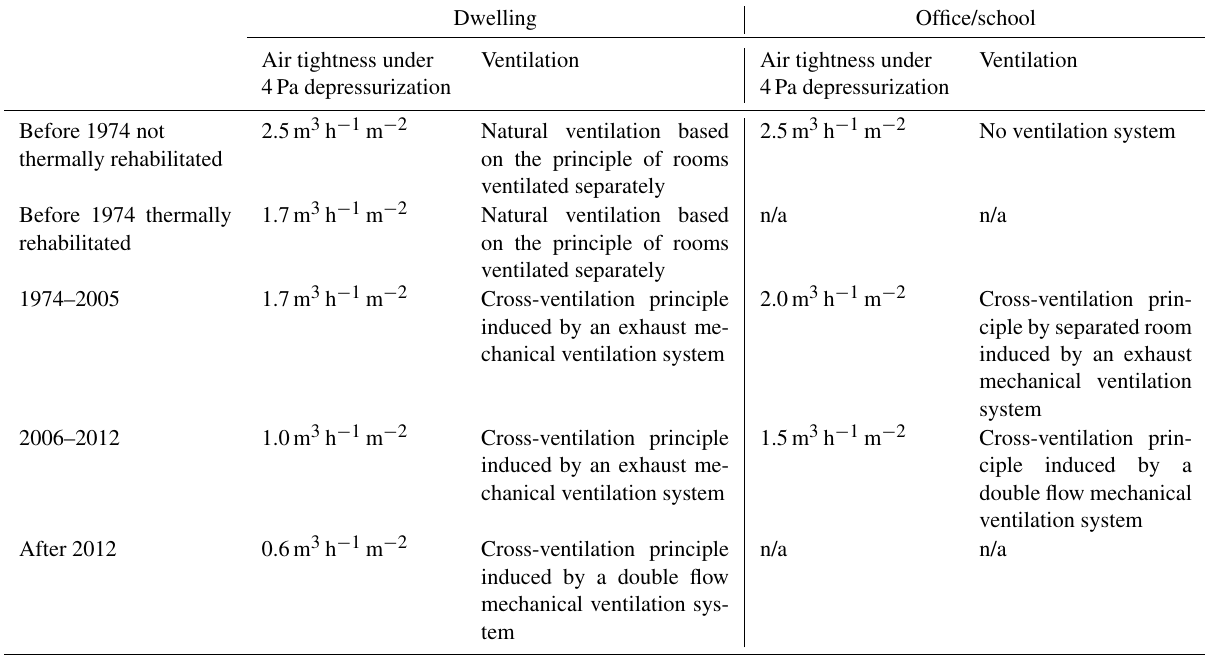
Table 2. Parameterization of the SIREN ventilation model depending on the construction date and the type of building, referring to the buildings’ air tightness and the ventilation